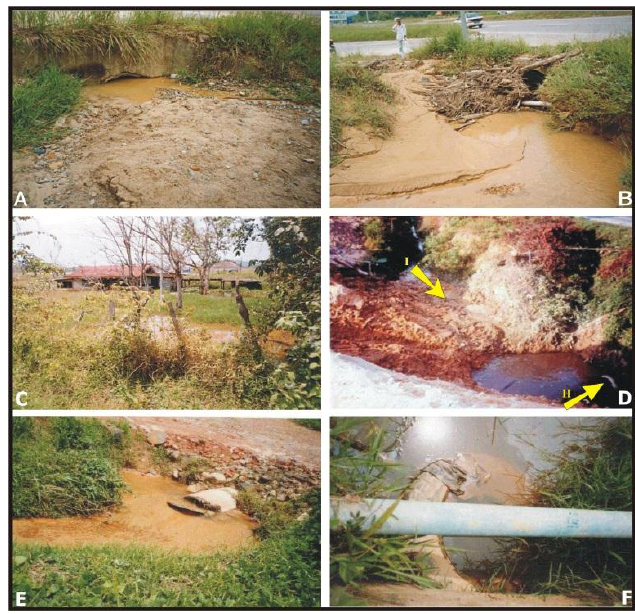
Figure 5: Factor causing environmental problem in the study area. A. Clog along the drain. Small and shallow ditch and siltation in the upper part